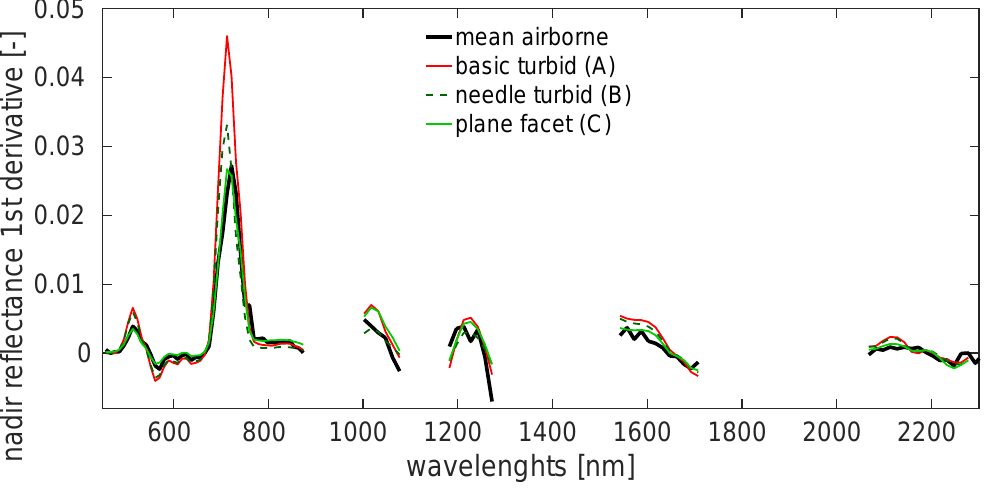
Figure 10. The first derivative computed for nadir spruce canopy reflectance simulated for three scenarios A , basic turbid , B , needle turbid , and C , plane facet , by DART and extracted from the airborne imaging spectroscopy data acquired with CASI and SASI sensors. The missing parts of spectral signatures are those wavelengths strongly impacted by atmospheric water vapour